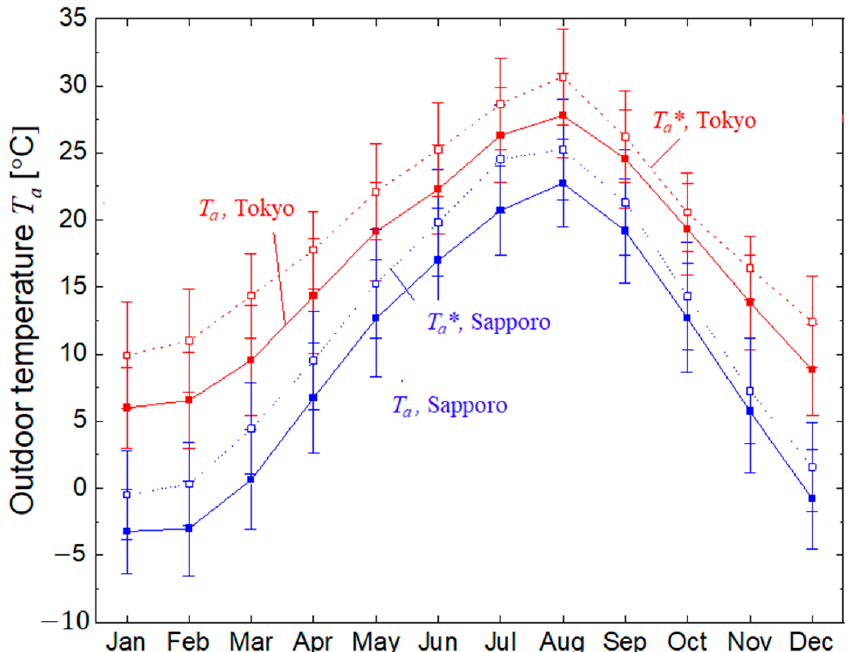
Figure 3. Monthly averages of outdoor temperatures with standard deviation for Sapporo and Tokyo, Japan, for the present (2001–2020) and future (2076–2095).